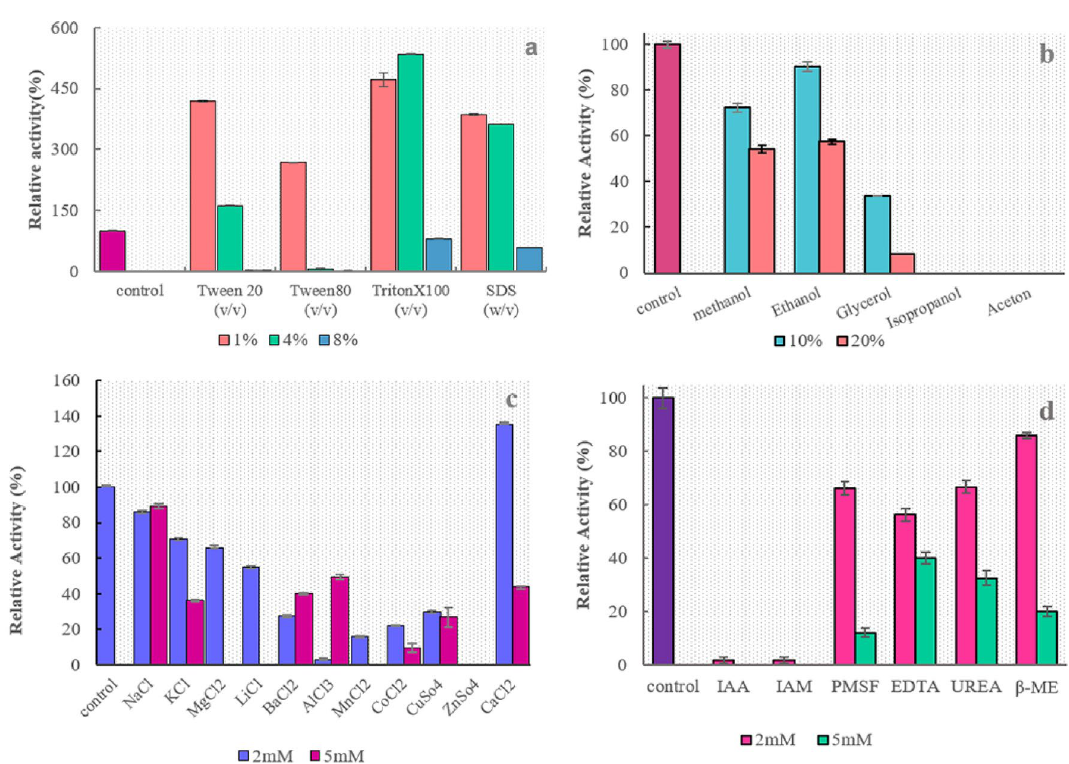
Figure 11. The effect of ( a ) surfactants, ( b ) organic solvents, ( c ) metal ions and ( d ) inhibitors on rEla relative